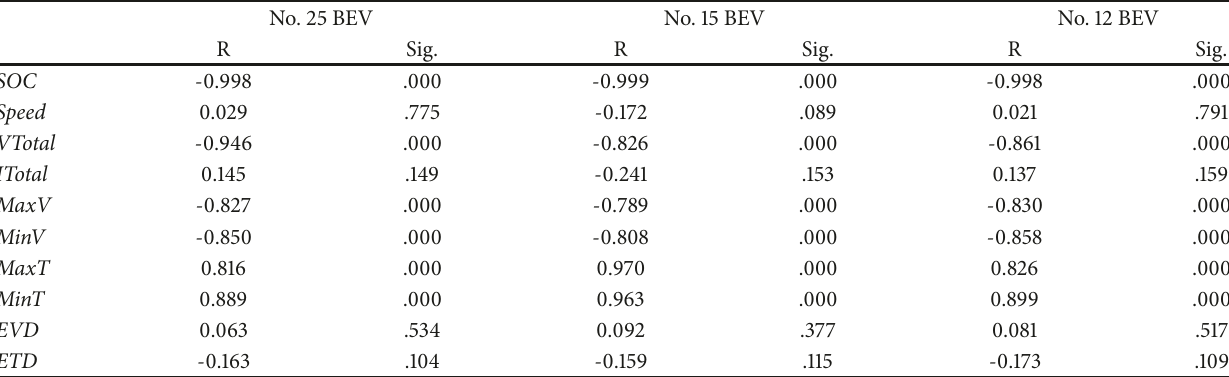
Table 3: Correlation test result between parameters and driving